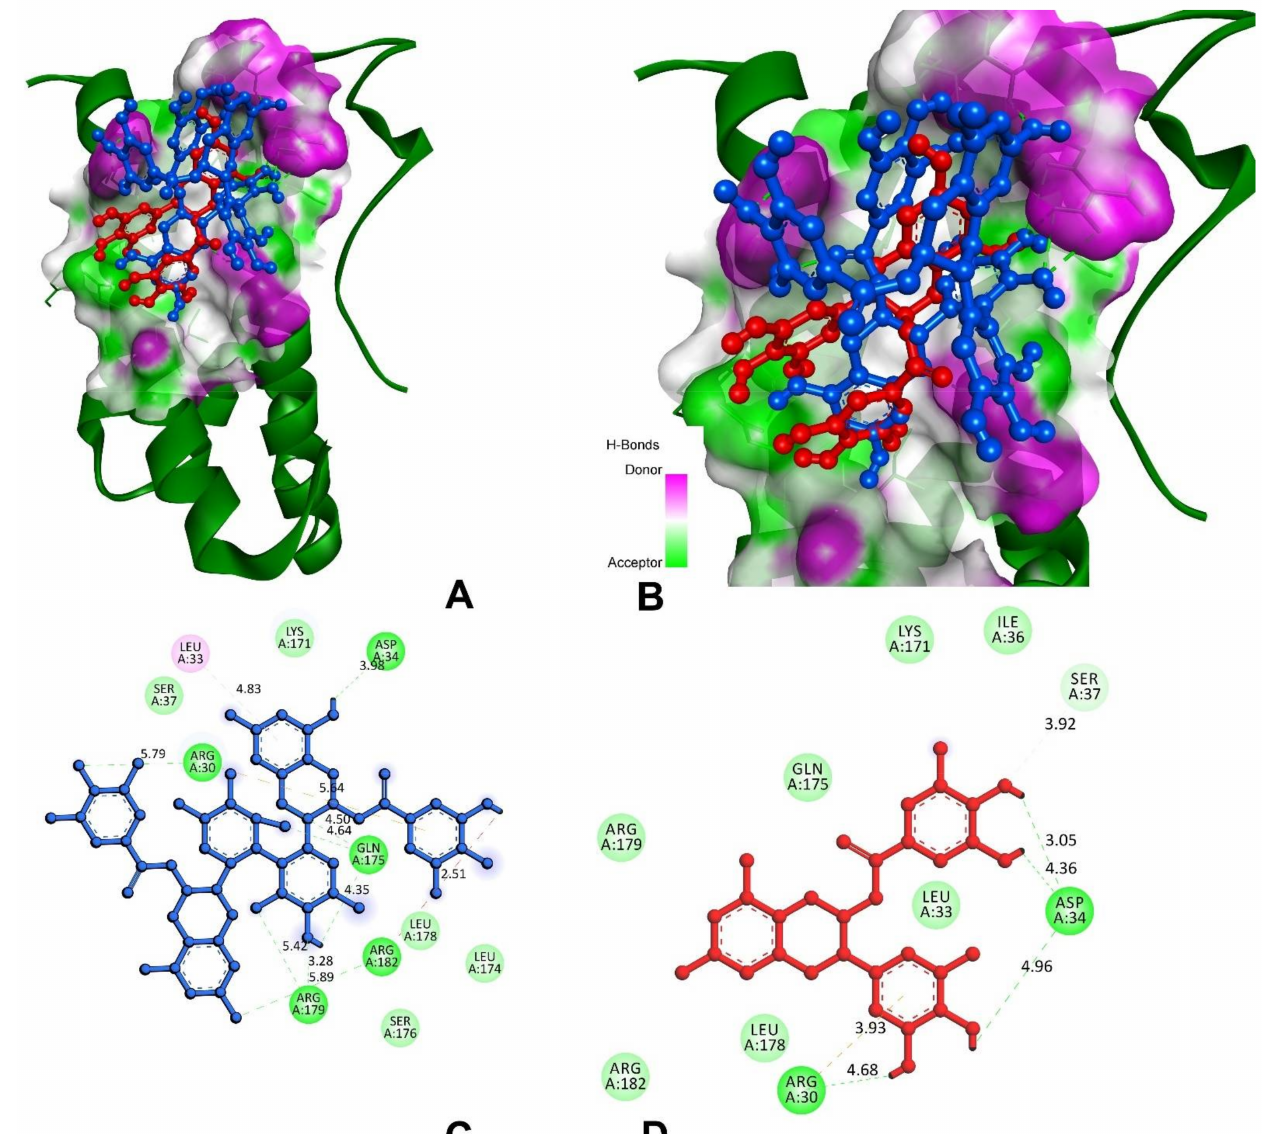
Figure 10. Molecular docking and interactions of IL-6 with theasinensin A and epigallocatechin gallate. ( A ) IL-6 ( green ) bound with compounds of theasinensin A ( blue ) and epigallocatechin ( red ). ( B ) Higher magnification of theasinensin A ( blue ) and epigallocatechin gallate ( red ) with IL-6. ( C ) Molecular interactions of IL-6 and theasinensin A ( blue ). ( D ) Molecular interactions of IL-6 and epigallocatechin ( red